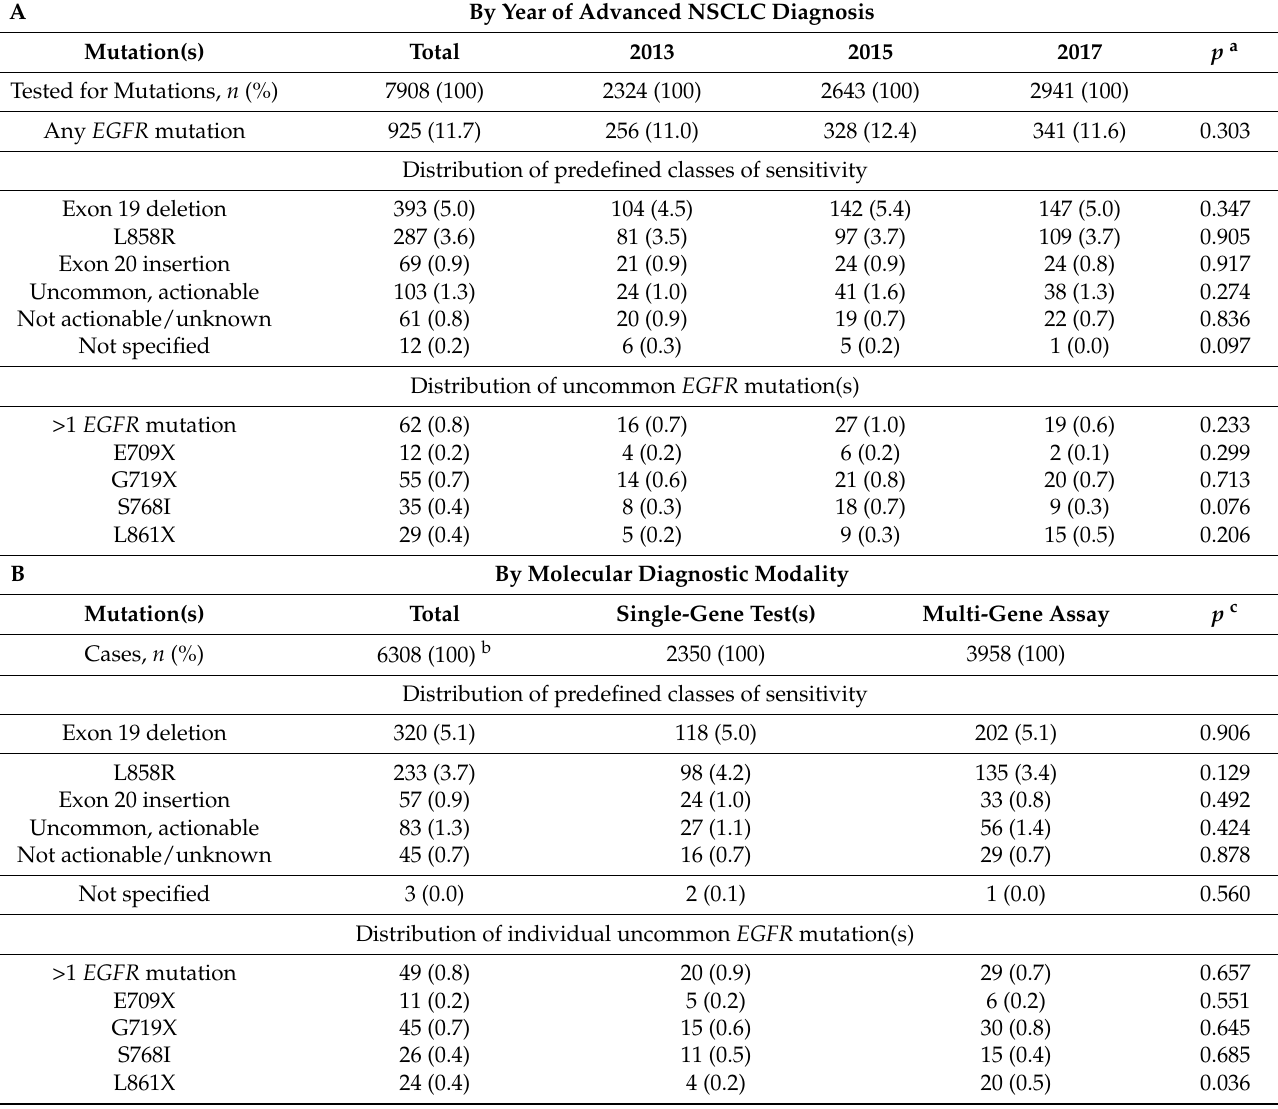
Table 2. EGFR mutations in the Dutch population of advanced non-squamous NSCLC patients by year of diagnosis (A) and molecular diagnostic modality